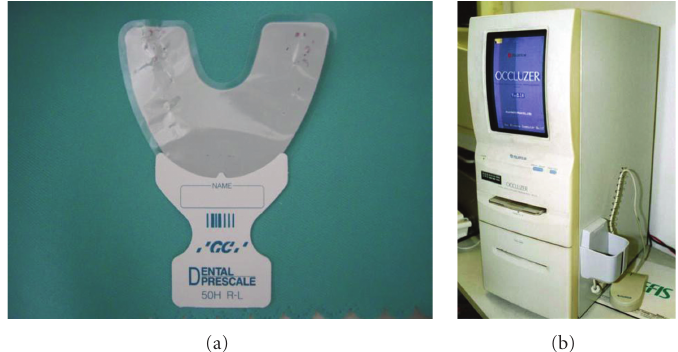
Figure 5: (a) A pressure-sensitive sheet (dental prescale), (b) an occlusal diagnostic system (dental prescale occluzer).